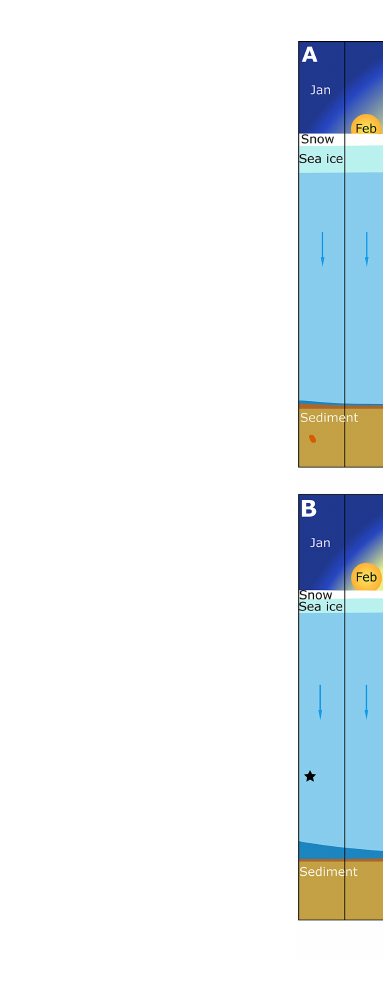
FIGURE 5 Schematic representation of the seasonal distribution, sinking and benthic assimilation of sympagic (orange) and pelagic (blue) organic matter in both the (A) northern (around 80°N) and (B) southern (around 77.5°N) sections of the study area. Surface primary production is dominated by the transition from a sympagic to pelagic bloom, followed by lower productivity in the late summer, autumn, and winter. The shaded area in the water column indicates the seasonal distribution of suspended organic matter. Arrows indicate sinking organic matter, with size representing magnitude and colour the dominance of pelagic or sympagic organic material. Estimates of the magnitude of assimilation of sympagic and pelagic organic matter are represented as plots at the seabed. Orange patches on the sediment represent patchiness of sympagic organic matter, which decreases in availability from spring to winter. Black stars show the timing of sampling events for this study. This fi gure is adapted from Wassmann and Reigstad, 2011 (their Figure 2) to include representation of the fate of organic matter reaching the seabed, based on our data and other published